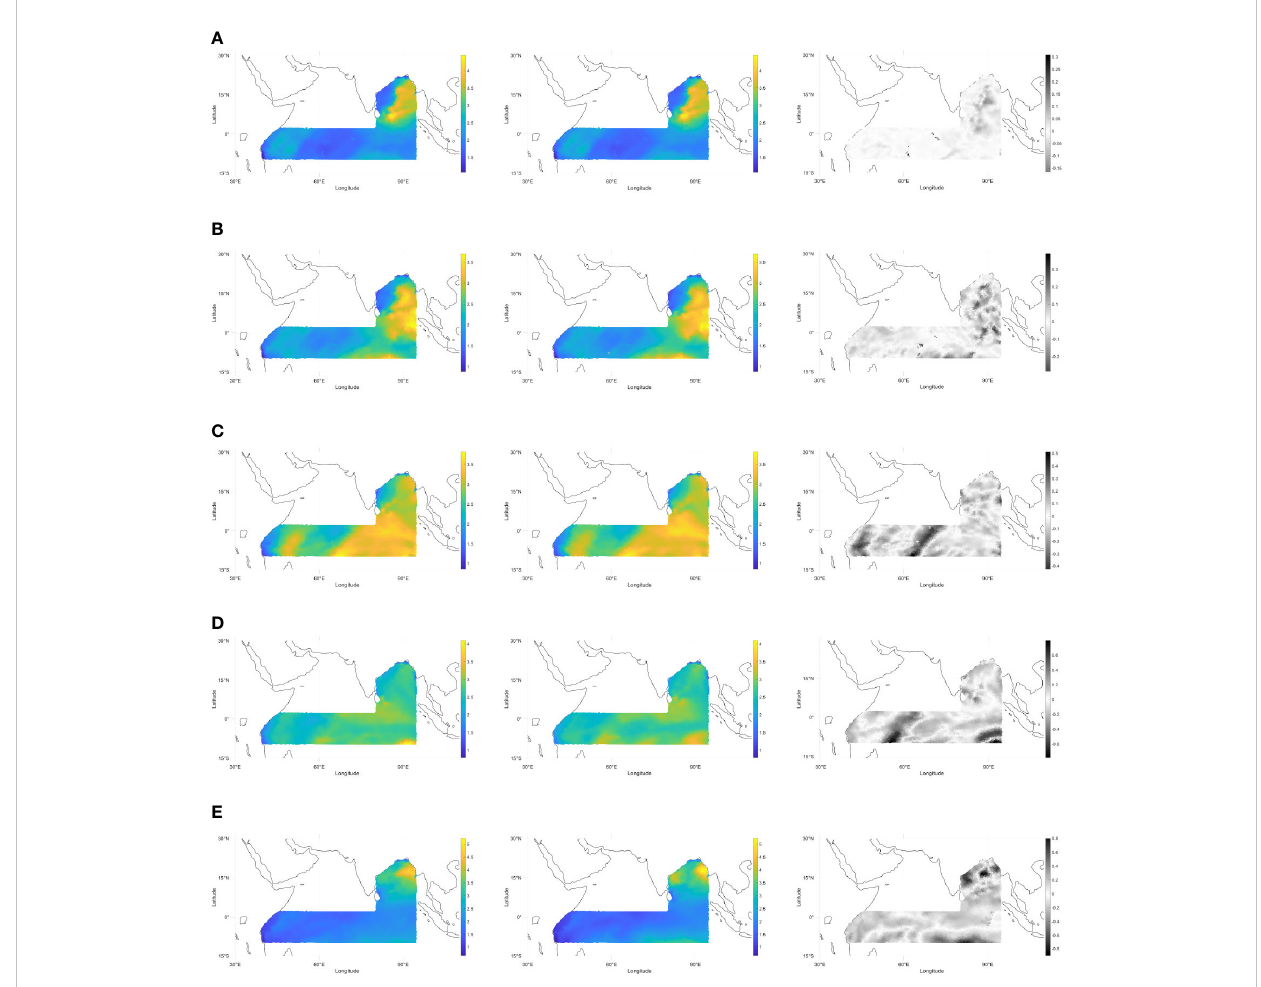
FIGURE 14 Prediction results of the EEMD-LSTM model for the future SWH from 1 to 18 hours for the whole study area (A) 1 hour, (B) 3 hours, (C) 6 hours, (D) 12 hours, (E) 18 hours. Coordinate axes are in